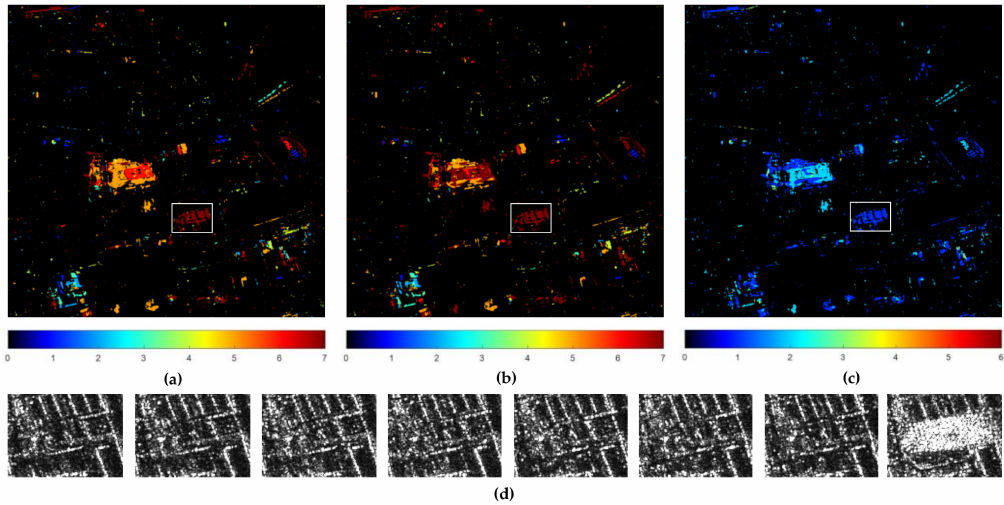
Figure 11. Multidimensional temporal change maps: ( a ) map when the first detected changes happened; ( b ) map when the last detected changes happened; ( c ) change frequency map (number of changes); ( d ) change process of buildings in the white box area over